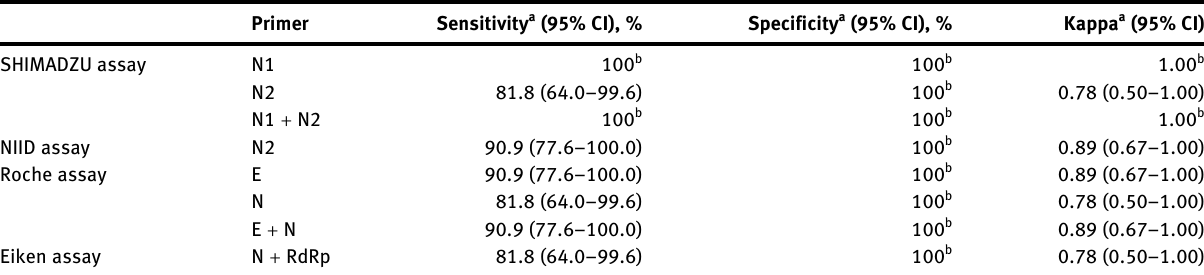
a Calculatedagainstthede fi nedreferencestandard. b  %CIcouldnotbecalculated.CI,con fi denceinterval;NIID,NationalInstituteofInfectious Diseases; RdRp, RNA-dependent RNA